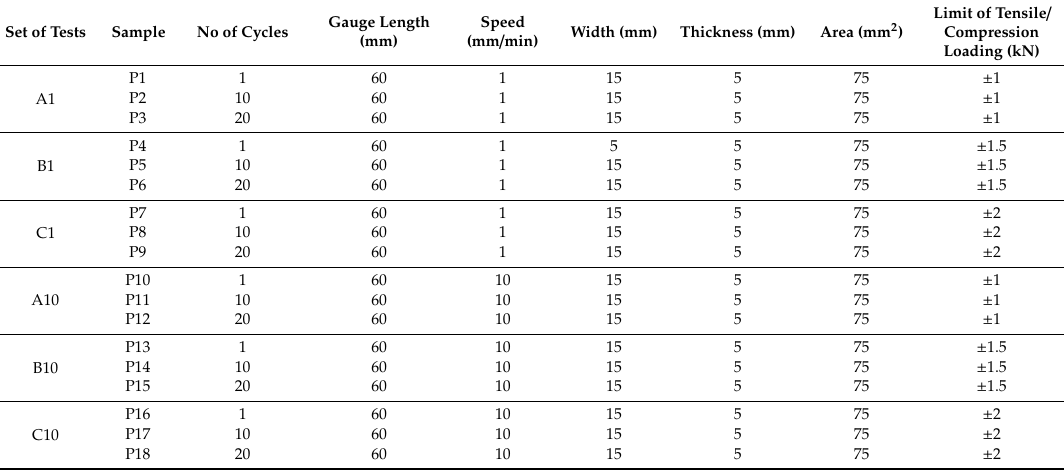
Table 1. Input data for experimental